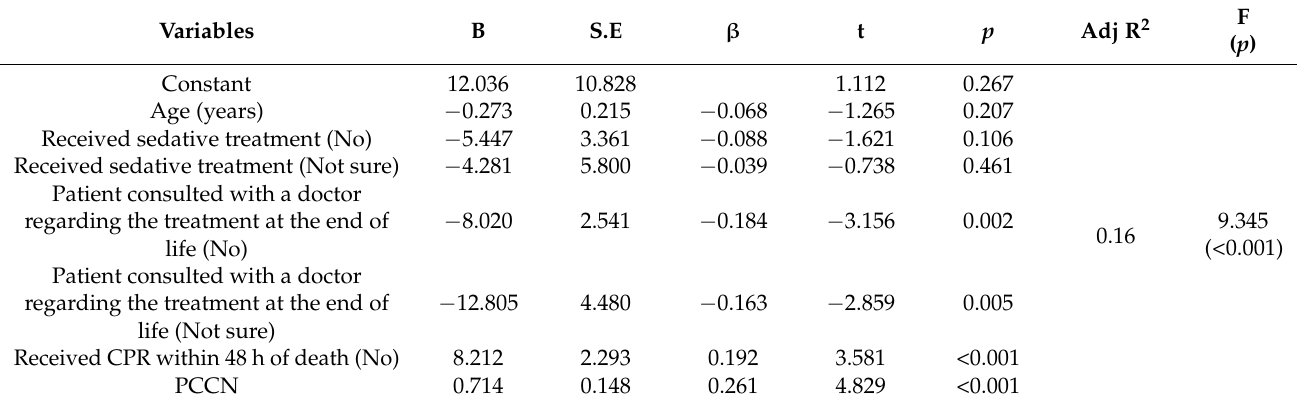
Table 5. Factors associated with QODD (N =